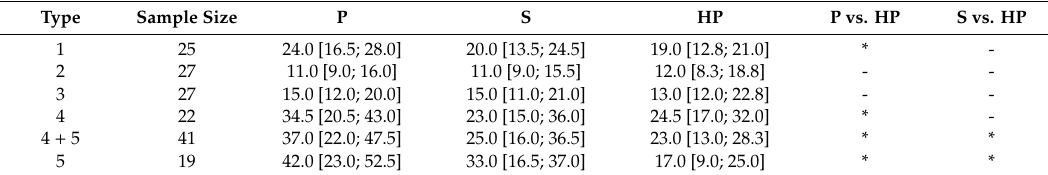
Table 5. Median and interquartile range of lesion dimensions grouped in different histopathologic types.